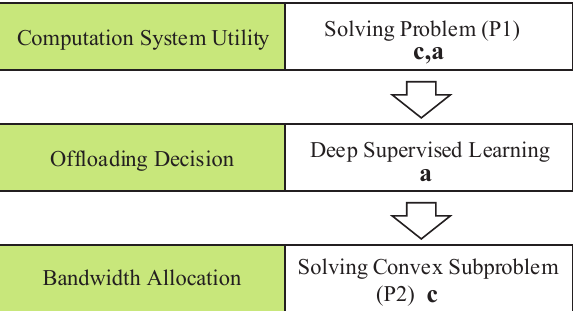
Figure 2. The two-level optimization structure for solving the problem